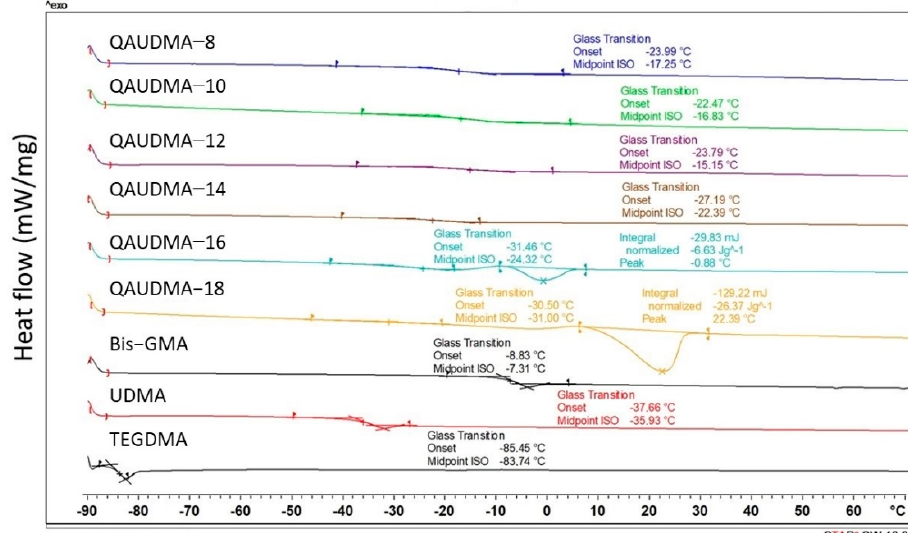
Figure 9. DSC thermograms of QAUDMAs, showing their T g .